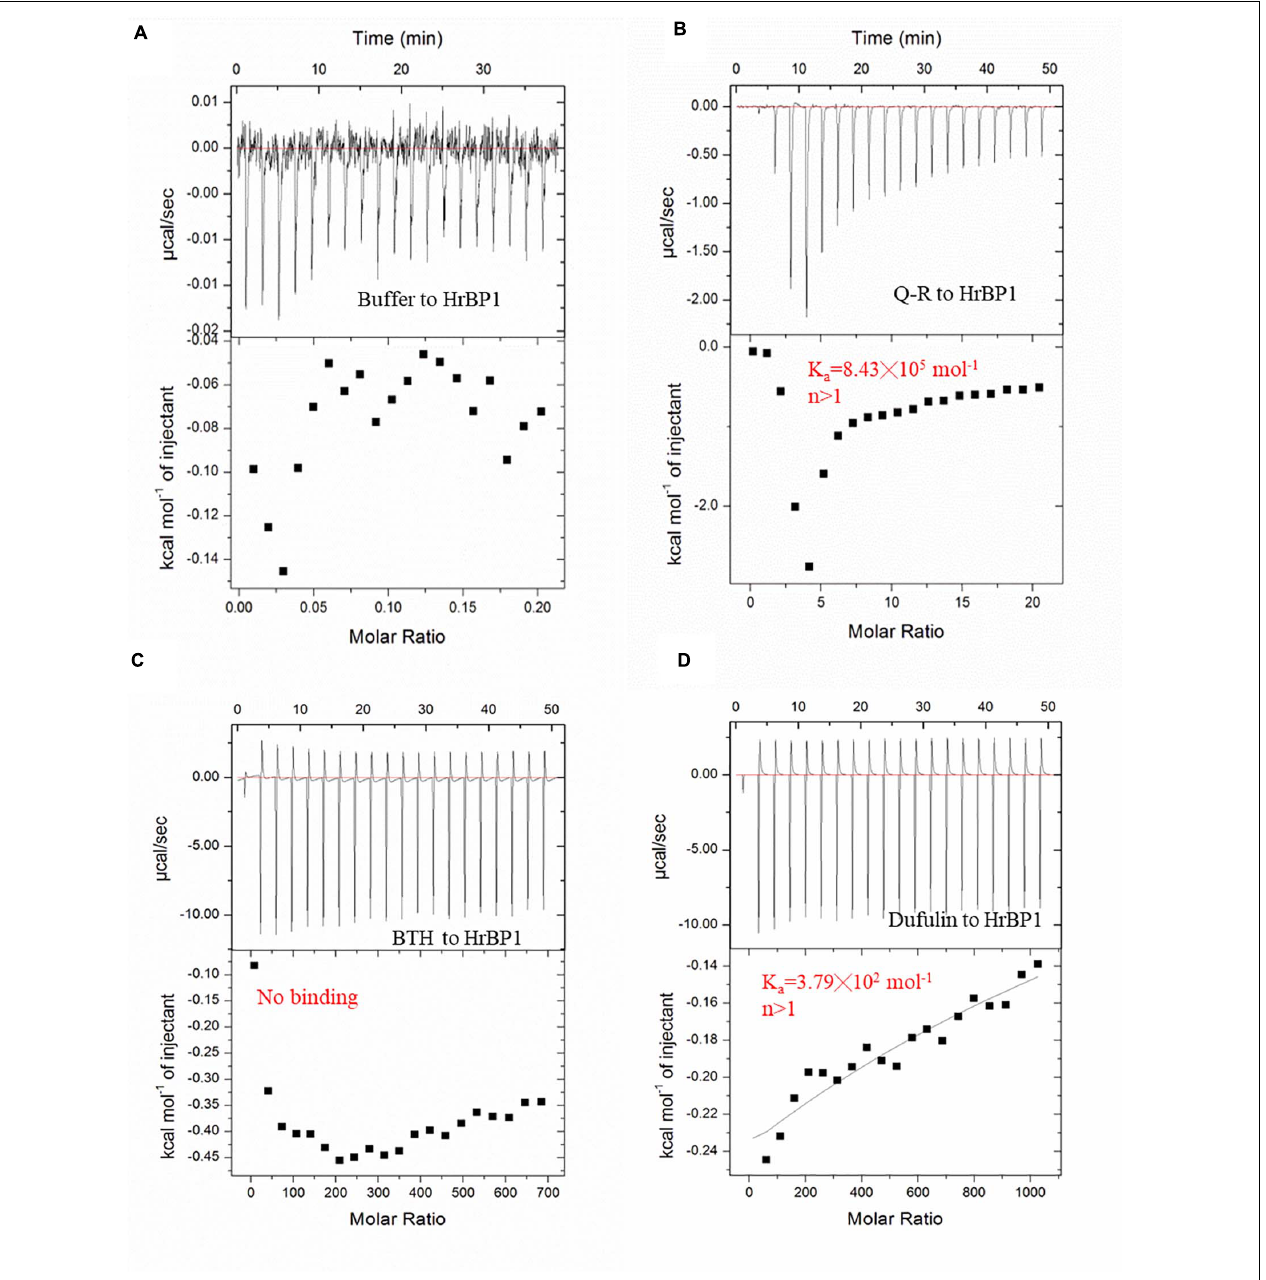
FIGURE 4 | ITC studies of Q-R, dufulin, BTH and HrBP1 purification protein. (A) control. (B) Q-R and HrBP1. (C) BTH and HrBP1. (D) Dufulin and HrBP1.